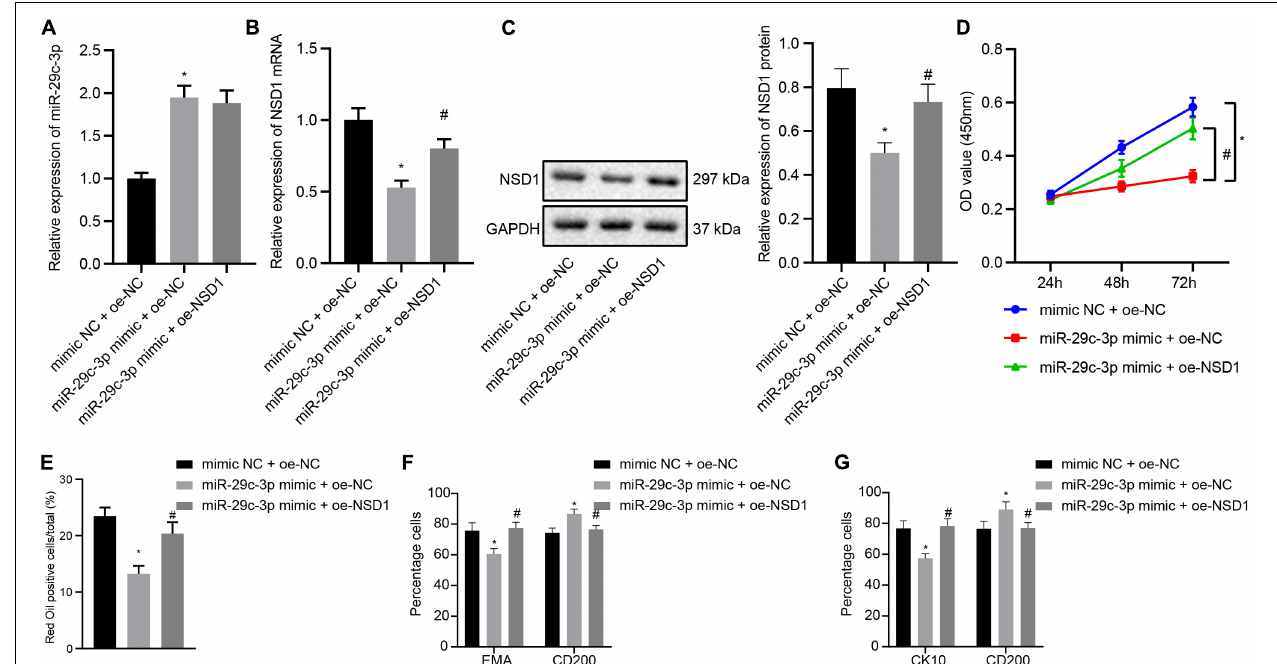
FIGURE 5 | NSD1 overexpression reverses the effects of miR-29c-3p to promote HFSC differentiation. (A) miR-29c-3p expression in HFSCs was determined by RT-qPCR. (B) NSD1 mRNA expression in HFSCs determined by RT-qPCR. (C) . NSD1 protein level in HFSCs determined by Western blot analysis. (D) CCK-8 assay used to detect the proliferation rate of HFSCs. (E) Oil red O staining before and after differentiation of HFSCs into sebaceous gland cells. (F) Detection of EMA and CD200 expression before and after the differentiation of HFSCs into sebaceous gland cells using flow cytometry. (G) The detection of keratin CK10 and CD200 expression before and after the differentiation of HFSCs into epidermal cells using flow cytometry. * p < 0.05 compared with treatment of mimic NC + oe-NC. # p < 0.05 compared with treatment of miR-29c-3p mimic + oe-NC. The data are expressed as mean ± standard deviation. Comparisons among multiple groups were performed using one-way ANOVA and Tukey’s test. Comparisons among multiple groups at different time points were performed using two-way ANOVA and Bonferroni test. The experiment was repeated three times.